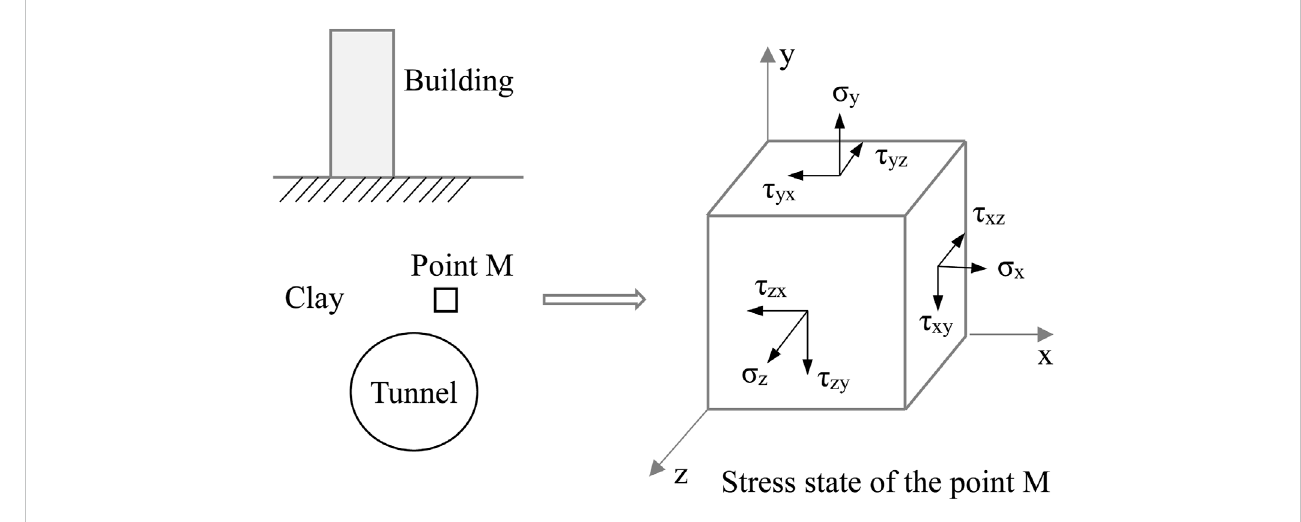
FIGURE 2 Stress state at a point in the clay tunnel surrounding